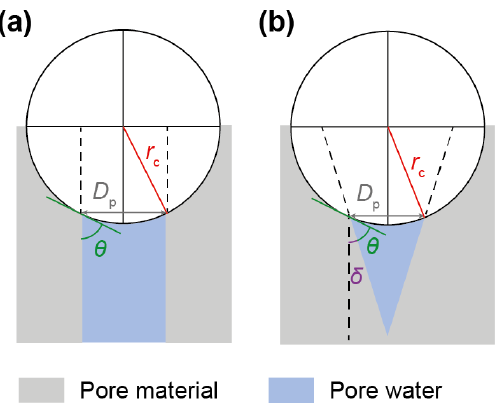
Figure B1. Illustration of radius of curvature r c of (a) cylindrical and (b) conical pores with pore diameter D p , contact angle θ sw , and pore-opening angle δ . For the cylindrical pore, δ is 0 ◦ .